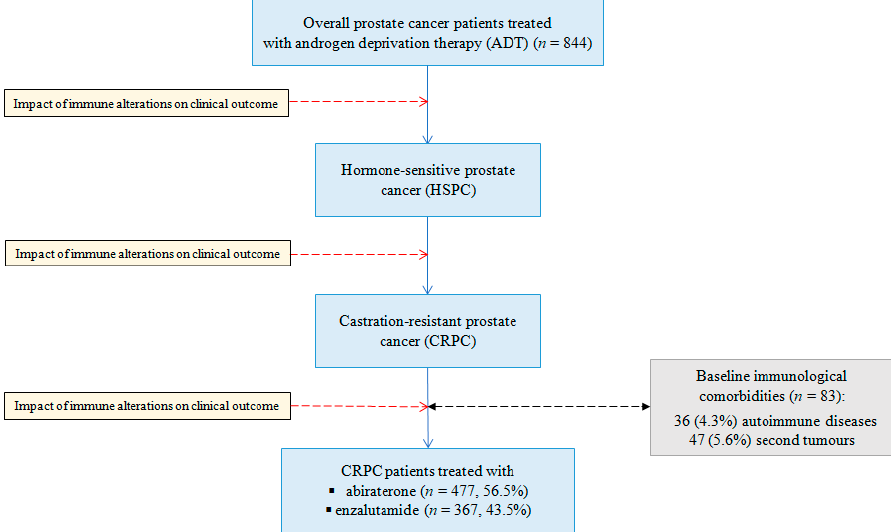
Figure 2. Flow chart of prostate cancer patient cohort included in this study.